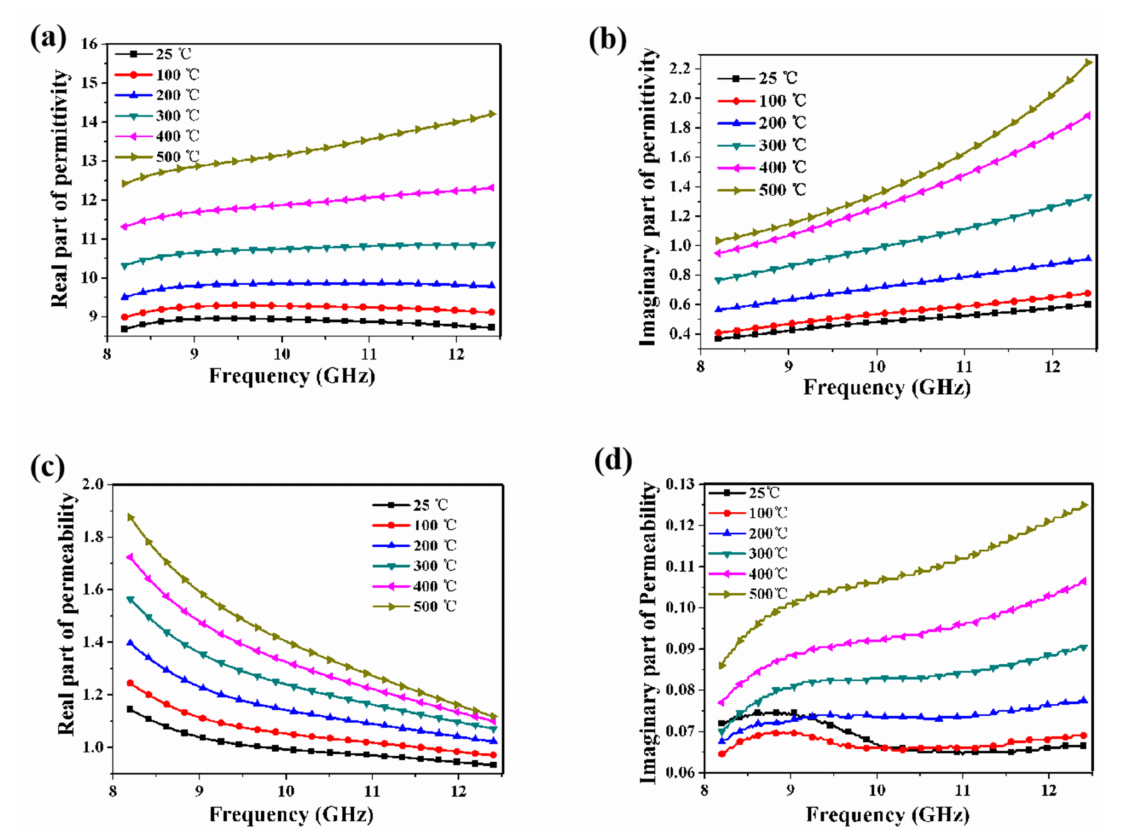
Figure 3. ( a ) Real part and ( b ) imaginary part of the complex permittivity of La 0.5 Sr 0.5 CoO 3 /Al 2 O 3 ceramic. ( c ) Real part and ( d ) imaginary part of the complex permeability of ceramic layer.